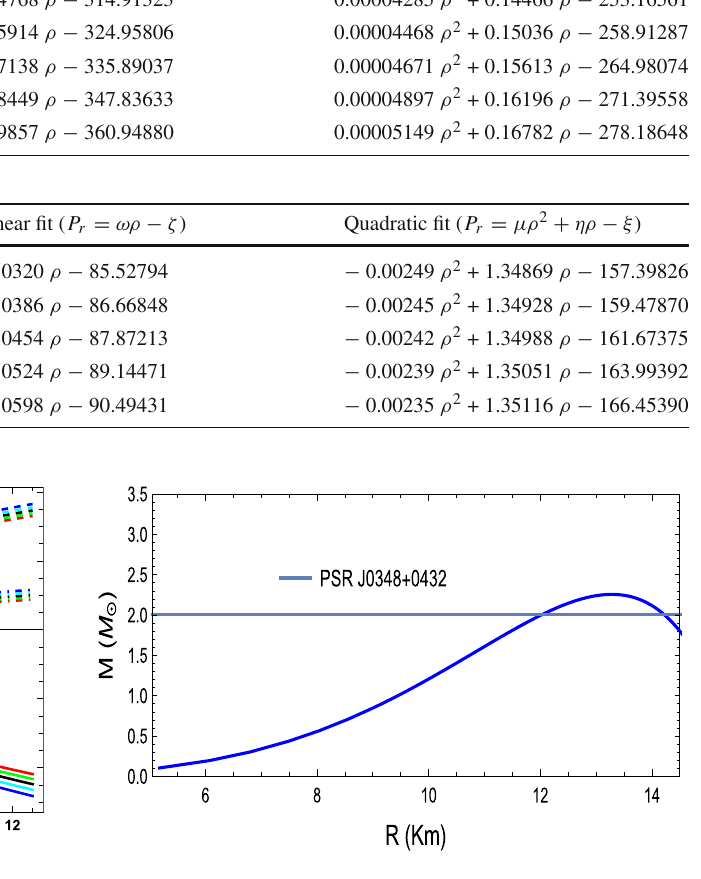
EoS for PSR J0348+0432 for different values of α in 5D